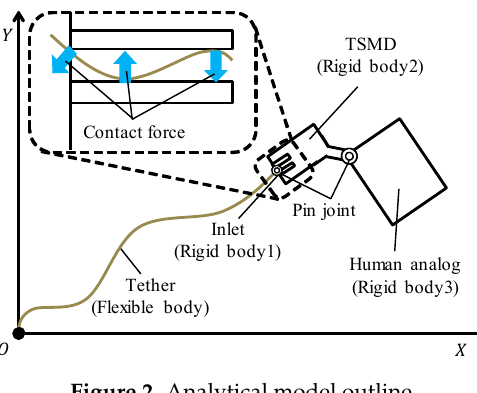
Figure 2. Analytical model outline.